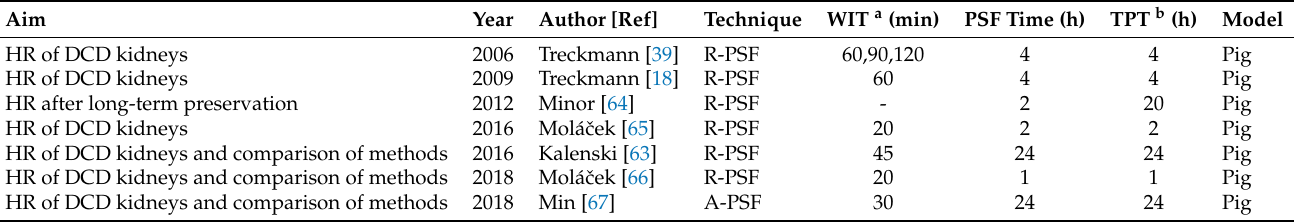
Table 2. Recent Persufflation work on the